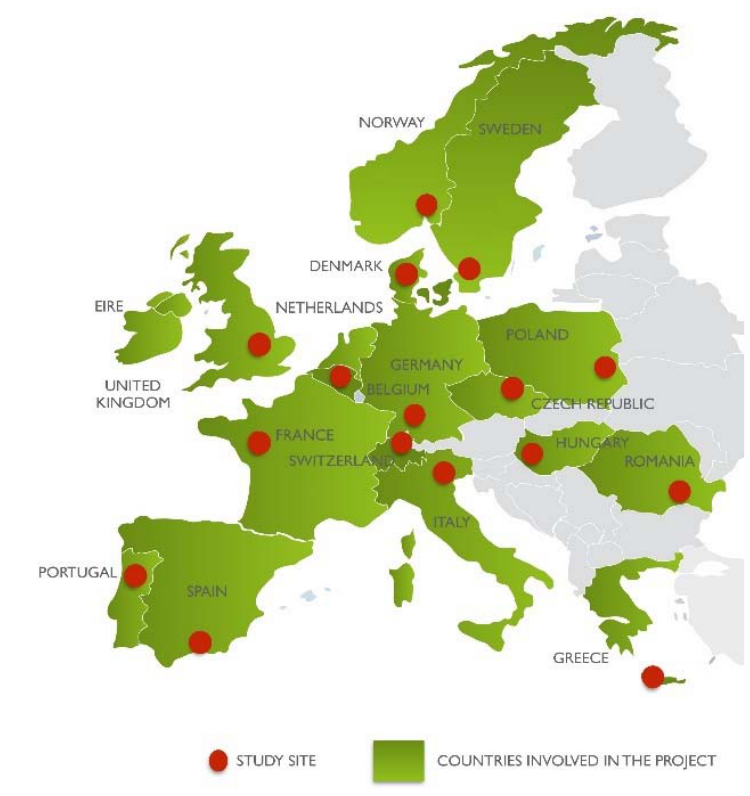
Figure 3. The 16 SoilCare study sites. Details on each study site can be found in Table 1. Within the study sites, different SICS were selected, tested in field, and evaluated in collaboration with stakeholders. Evaluation of SICS was conducted by applying the same assessment methodology at each study site. This general methodology was based on a shared database [78], a common monitoring plan, a unified statistical analysis